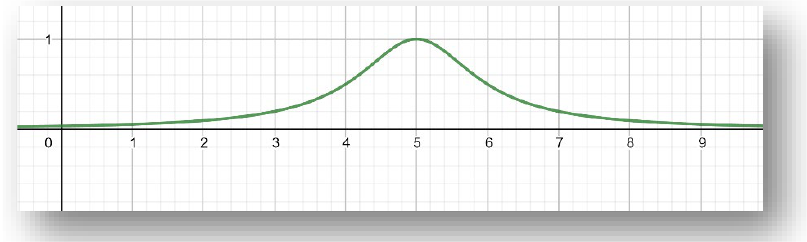
Figure 1. Membership function graph A ( x )